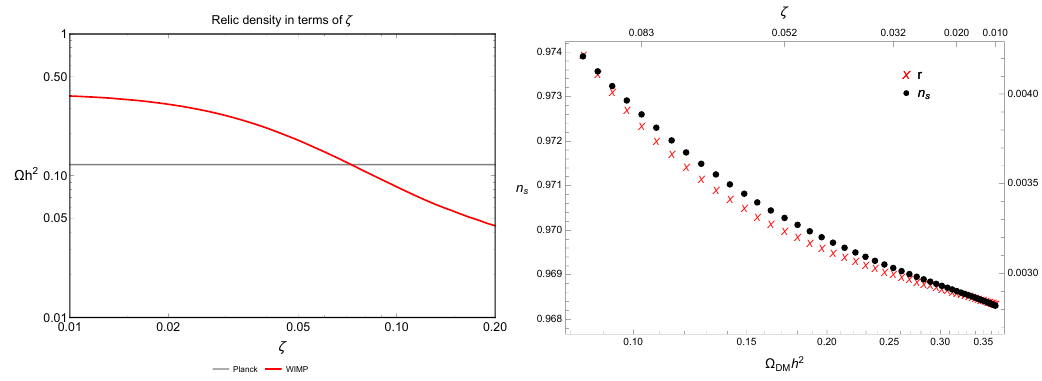
Figure 3 . (Left) Relic density for WIMP dark matter as a function of (cid:16) . (Right) Relic density in the plane of spectral index and tensor-to-scalar ratio. The parameters are chosen as follows: sin (cid:18) = 0 : 01, " = 10 (cid:0) 4 , g X = 0 : 1, m h 0 = 100 GeV, m (cid:31) = 500 GeV, (cid:21) (cid:30) = (cid:21) (cid:31) = (cid:21) (cid:30)(cid:31) = (cid:21) (cid:31)H = 0 : 1, thus m Z 0 = 67 GeV. The gray horizontal solid line on left represents the Planck data for the relic